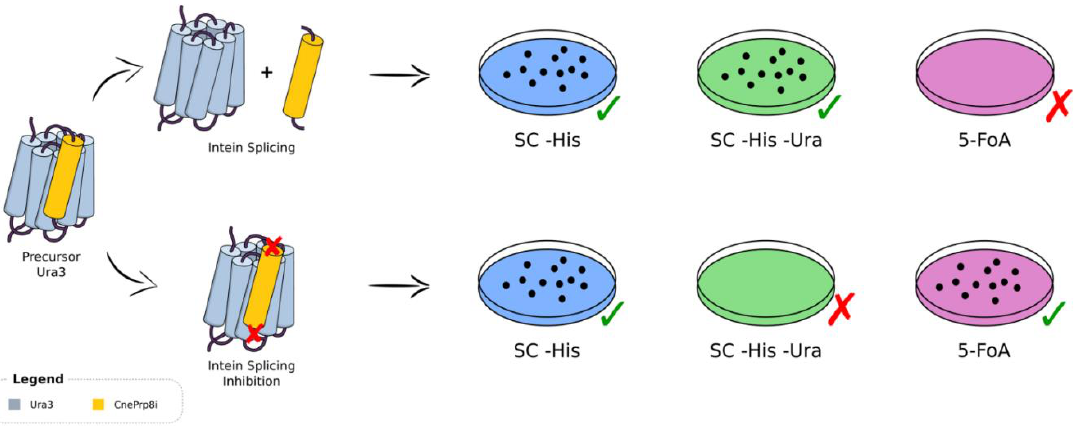
Figure 1. An overview of the system. Intein splicing might occur normally (top) or be inhibited (bottom), which would be visualized by the different growth patterns generated in given media (left side panel). SC -His: synthetic complete medium without histidine; SC -His -Ura: synthetic complete medium without histidine and uracil; 5-FOA: SC -His -Ura medium with 5-fluoroorotic acid and uracil.